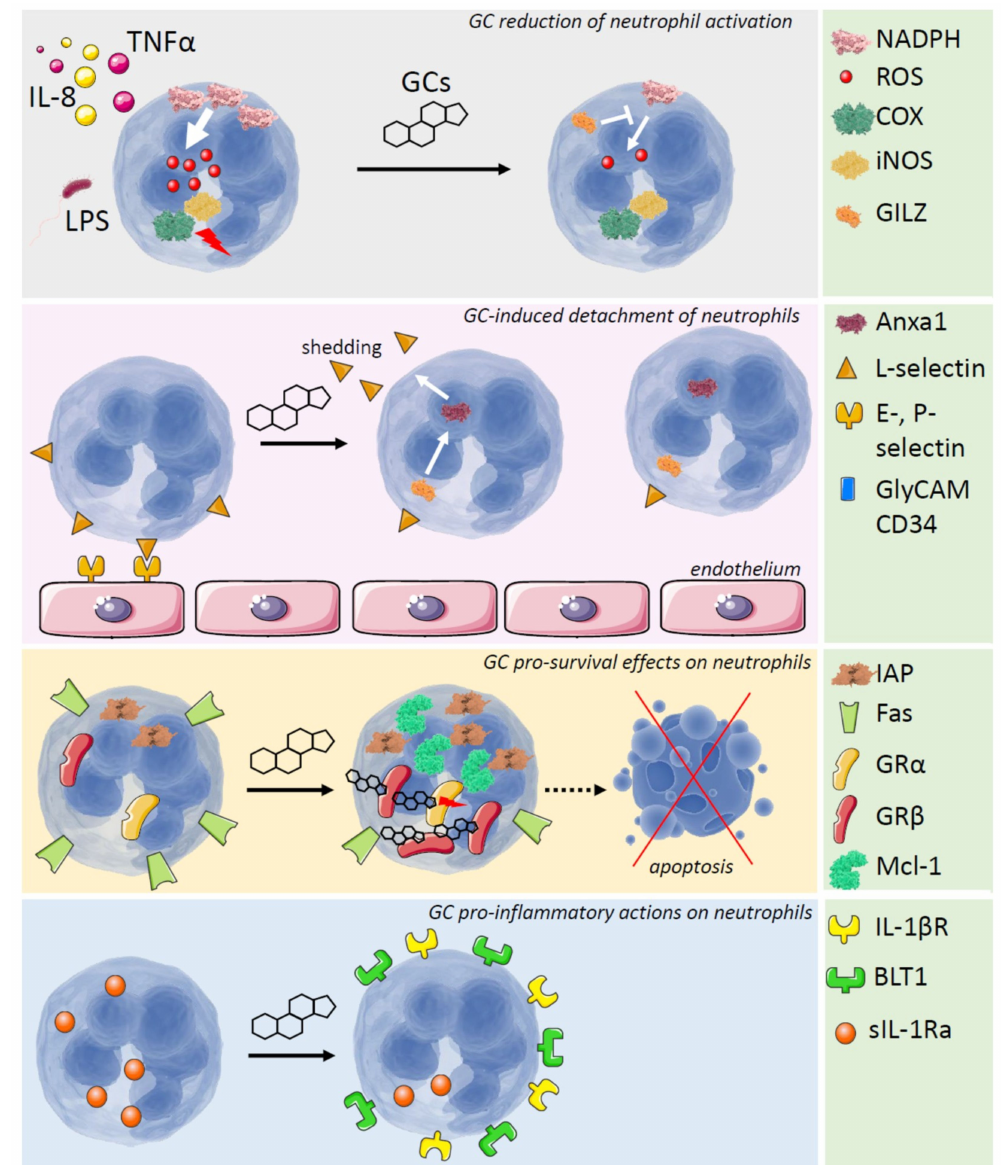
Figure 1. Multiple effects of GCs on neutrophils. From the top to the bottom: (1) the GC-induced anti-inflammatory protein GILZ mediates one of the GC-effects that lead to reduction of neutrophil activation, by inhibiting NADPH-dependent ROS production. COX and iNOS activities are also reduced by GCs; (2) Anxa1, which can be indirectly induced by GCs via GILZ, allows L-selectin shedding, thus favoring detachment of the neutrophils from the endothelium; (3) GCs promote neutrophil survival via several mechanisms: downregulation of the pro-apoptotic surface Fas receptor, upregulation of the pro-survival IAP protein family, upregulation of the anti-apoptotic Mcl-1 protein, and increased levels of the GR- β isoform; (4) the GC pro-inflammatory effects on neutrophils depend on an increase of IL-1 β R expression levels, a reduction of sIL-1 β Ra, and an increase of BLT1 receptor for leukotrienes. White arrows indicate production of ROS or activation of a downstream protein; bars indicate inhibition of a protein function; dotted arrows indicate a prevented